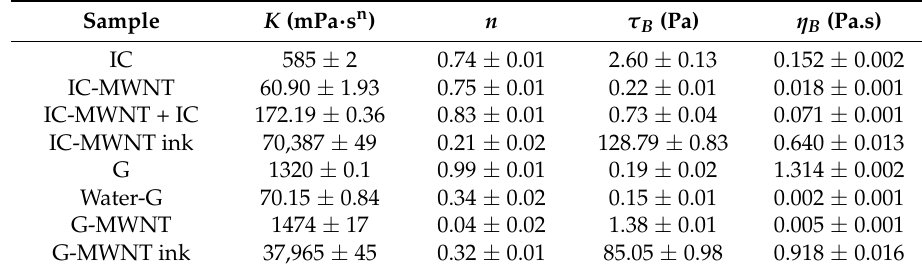
Table 1. Summary of rheological analysis at a shear rate range of 10–100 s − 1 and 21 ◦ C for printed IC-MWNT and G-MWNT inks. Concentrations of IC, CNT and G are 1.5% w / v , 0.10% w / v and 0.38% w / v , respectively Consistency ( K ) and power-law index ( n ) values were obtained through curve fitting with the power-law model (Equation (1)). Bingham yield point ( τ B ) and Bingham flow coefficient ( η B ) values were obtained using the Bingham model (Equation